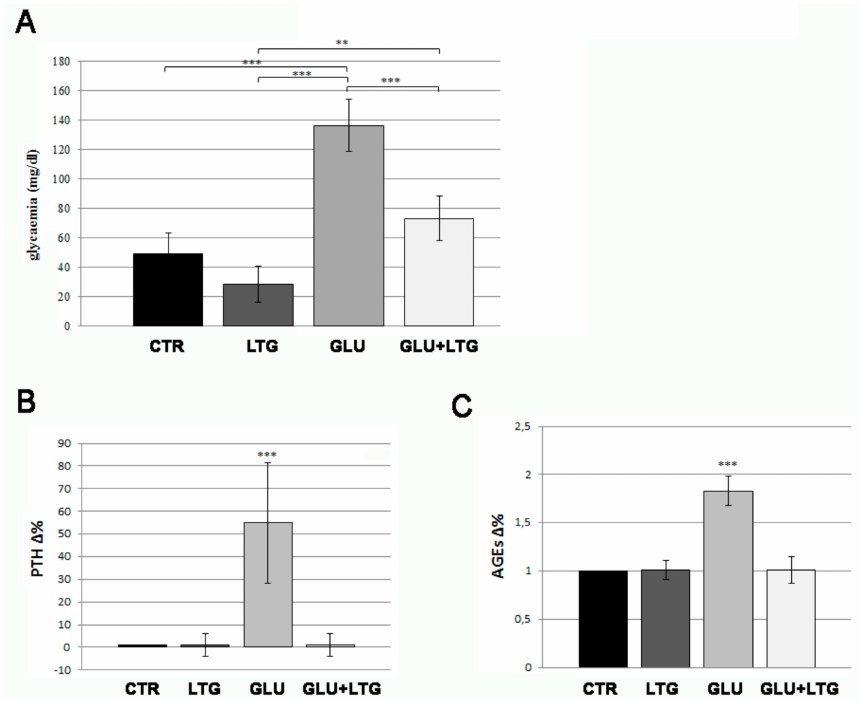
Figure 1. ( A ) Basal blood glucose measurement. Fish treated with glucose (GLU) were compared to control fish (CTR), LTG-treated fish (LTG), and glucose / LTG (GLU + LTG) co-treated fish (CTR vs. GLU p < 0.001, LTG vs. GLU p < 0.001, GLU + LTG vs. GLU p < 0.001). Parathormone (PTH) ( B ) and advanced glycation end-products (AGEs) ( C ) dosage in fish blood. Blood level of AGEs and PTH of glucose-treated fish (GLU) were compared to control (CTR) and glucose / LTG-treated (GLU + LTG) fish (CTR vs. GLU, p < 0.001; GLU + LTG vs. GLU, p < 0.001). p < 0.01 (**) and p < 0.001